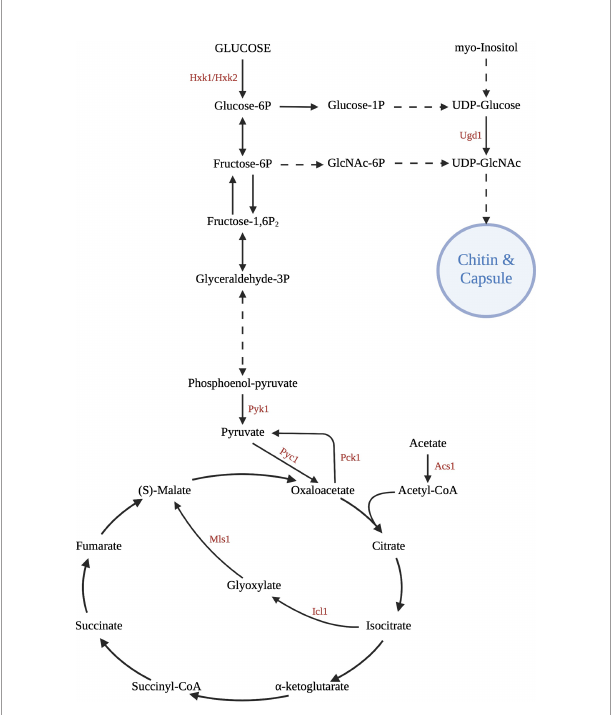
FIGURE 2 | Central carbon metabolism pathways. C. neoformans uses glycolysis, gluconeogenesis, the tricarboxylic acid cycle, and the glyoxylate shunt for growth and survival in the host. Various gene deletion mutants have been created at important enzymatic points in these pathways to investigate the effect on virulence. Of great importance is the ability to use these intermediates and products to assemble the capsule and cell wall, major carbon-based virulence factors of Cryptococcus . Created with